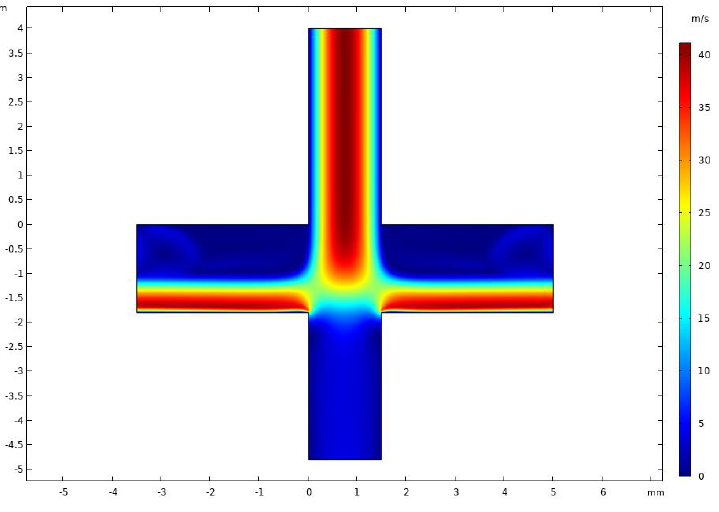
Figure 13. Pressure distribution of VI using CO 2 as fluid.